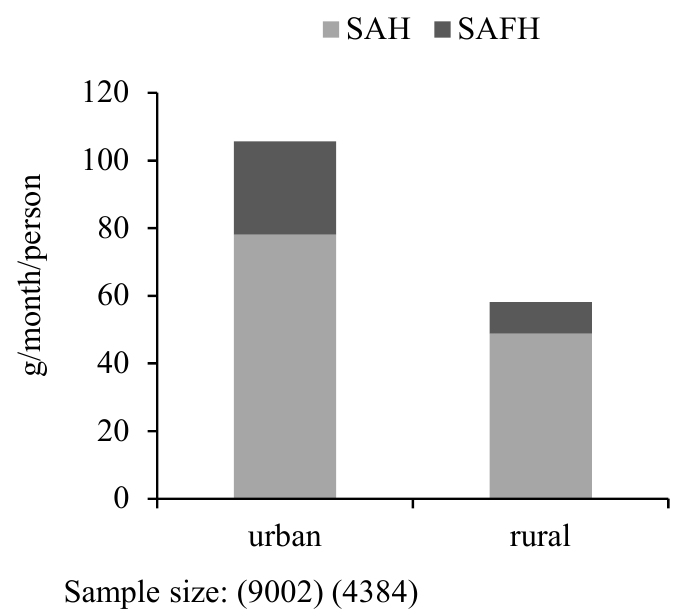
Figure 2. Seaweed consumption between urban and rural residents.